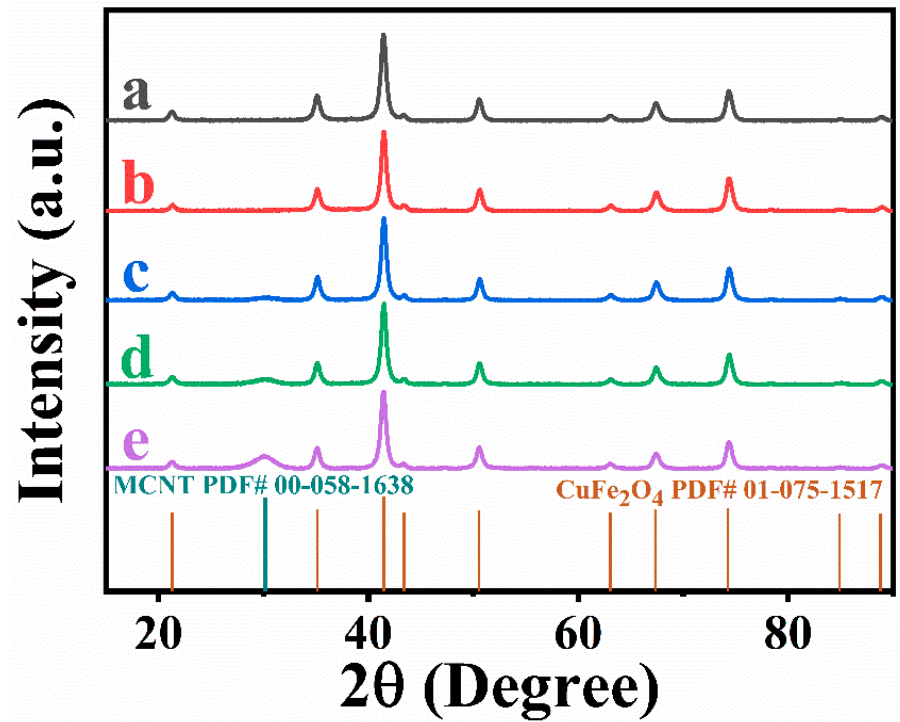
Figure 5. XRD data for (a) as-received CuFe 2 O 4 and electrodes: (b) CFO-0, (c) CFO-10, (d) CFO-20 and (e) CFO-30.